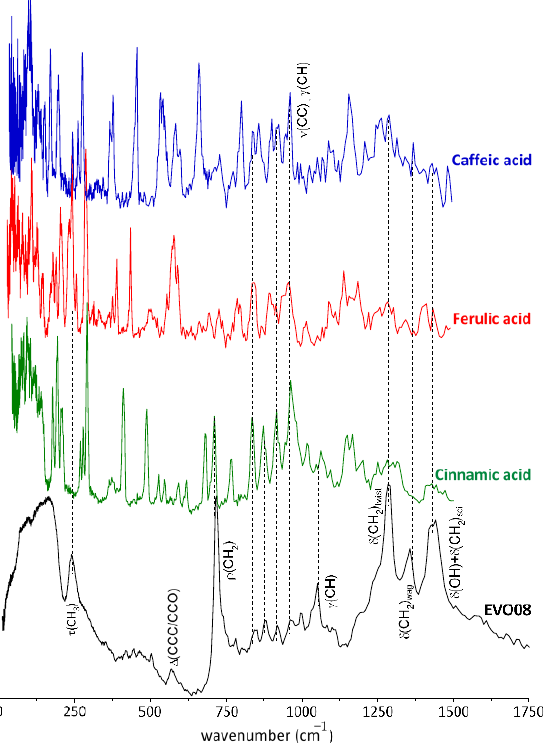
Figure 3. INS spectra (0–1750 cm − 1 ) of extra virgin olive oil (EVOO8) and some representative dietary phenols (cinnamic, caffeic and ferulic acids).